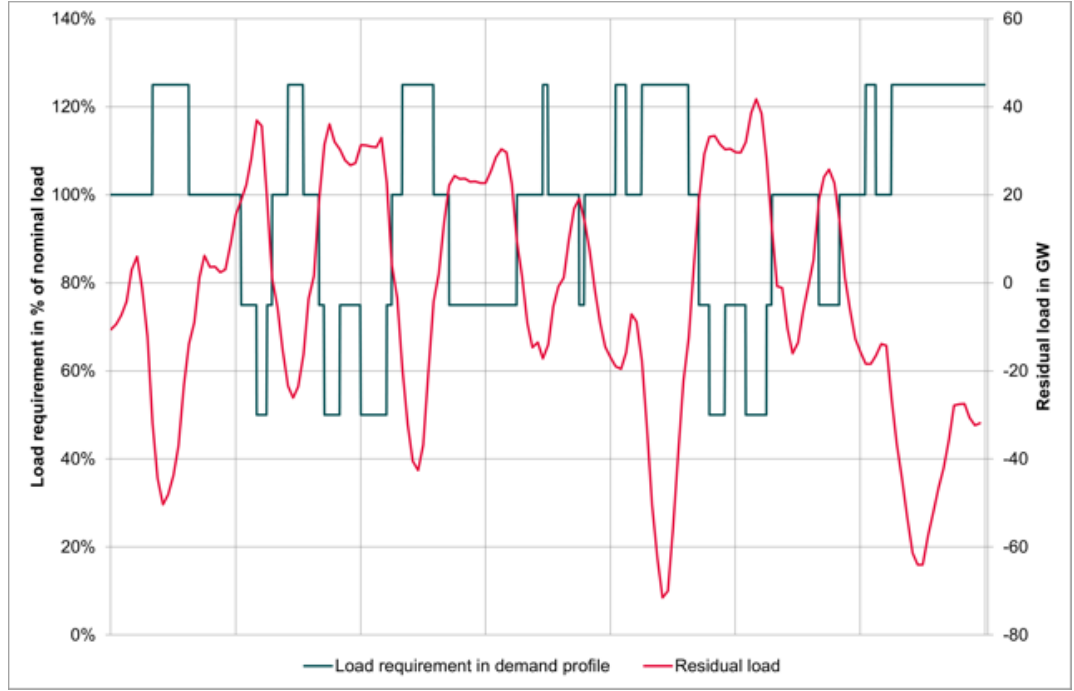
Figure 2. System related requirement profile for the laboratory solid-oxide electrolysis (SOEC) stack derived from the Technical University of Munich (TUM) reference scenario for week 27 in the year